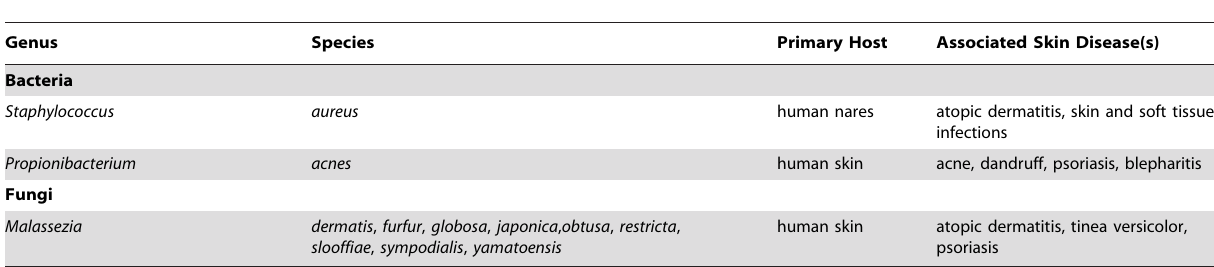
Table 1. Skin microbes discussed and their associated skin